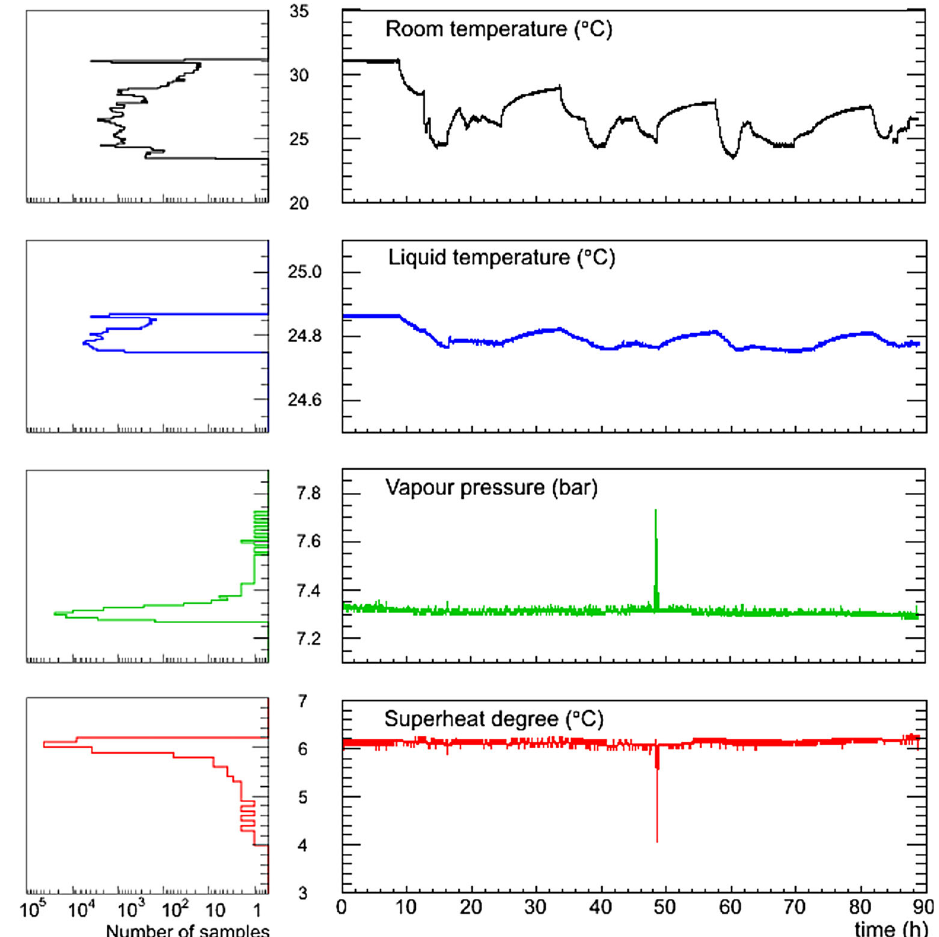
Fig. 2 Time-variations of the thermodynamic parameters during the 90 h-long run at (cid:2) T ∼= 6 ◦ C with only background radiation, with their distributions (from the top: room temperature; water bath temperature; vapour pressure; superheat degree)